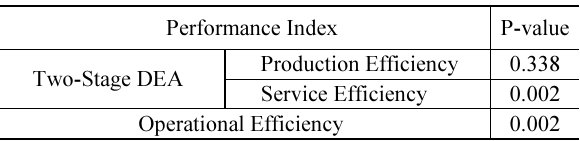
Table 9. The Kruskal Wallis test